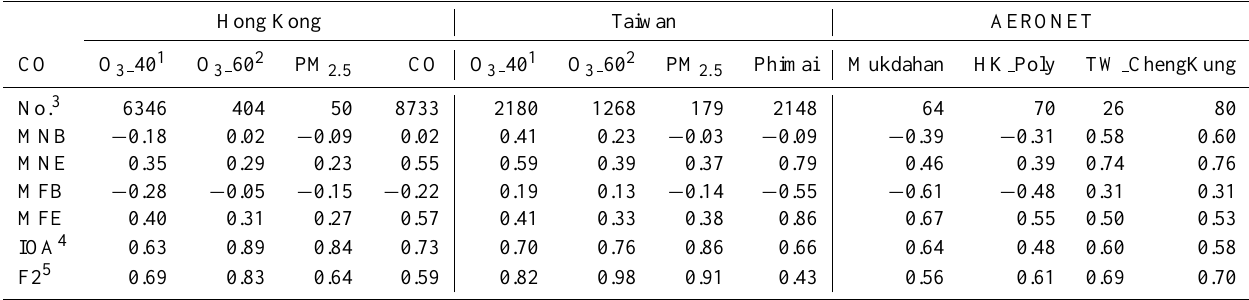
Table 3. Statistical parameters for model evaluation of CO, O 3 , and PM 2 . 5 in Hong Kong and Taiwan, and AOD at four AERONET sites. Definitions of all parameters are described in Appendix A. Hong Kong